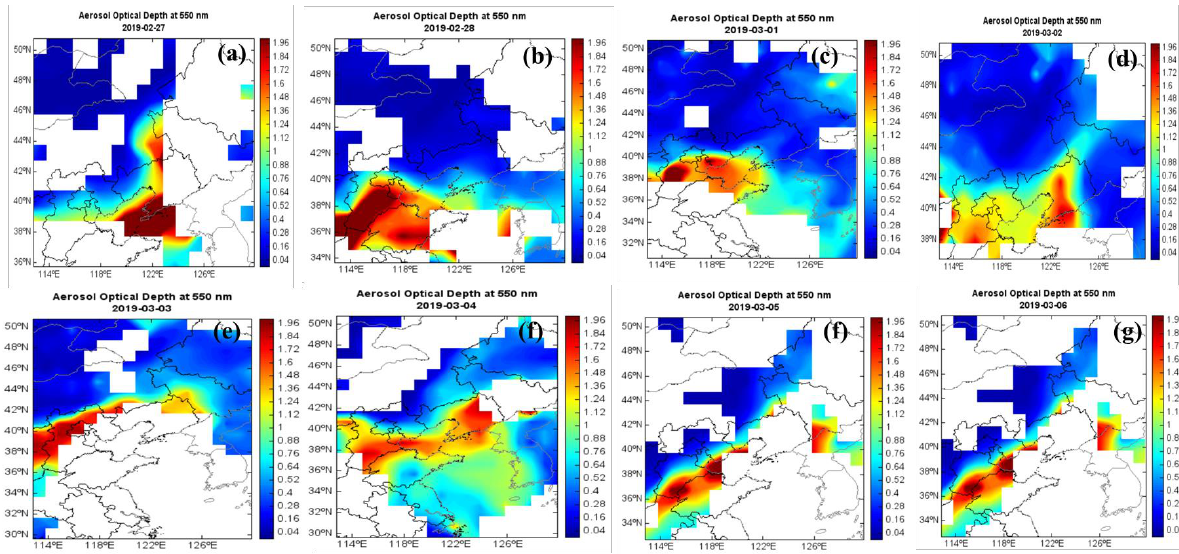
Figure 2. The aerosol optical thickness depth (AOD) of VIIRS from (a-g) 28 February to 6 March.